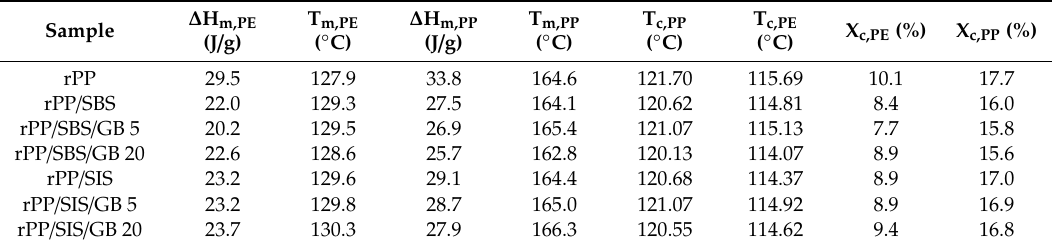
Table 4. DSC parameters for post-consumer rPP / TPE / GB